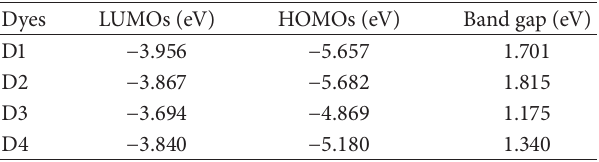
Table 1: FMO and band gaps of dyes D1 to